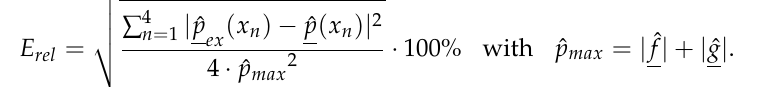
in nominal operation point at min